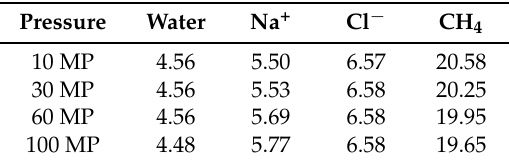
Table 6. Water coordination number under pressures of 10–100 MP.